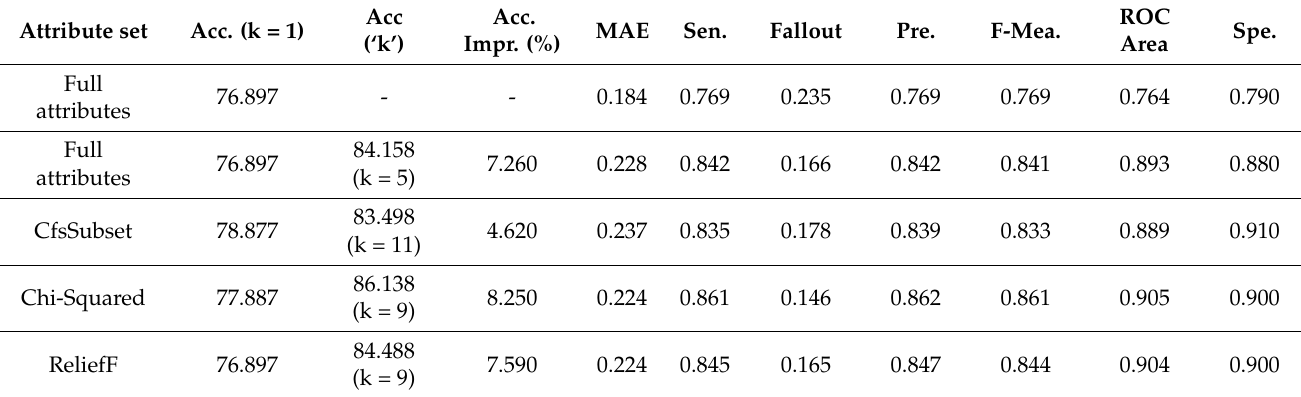
Table 12. Performance comparison of the KNN algorithm by tuning the parameter ‘k.’